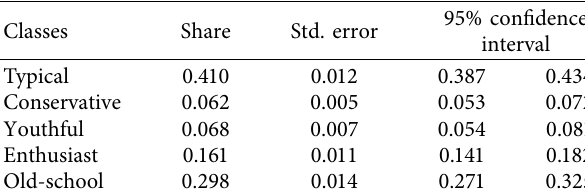
Table 3: Classes of consumers; share and statistical